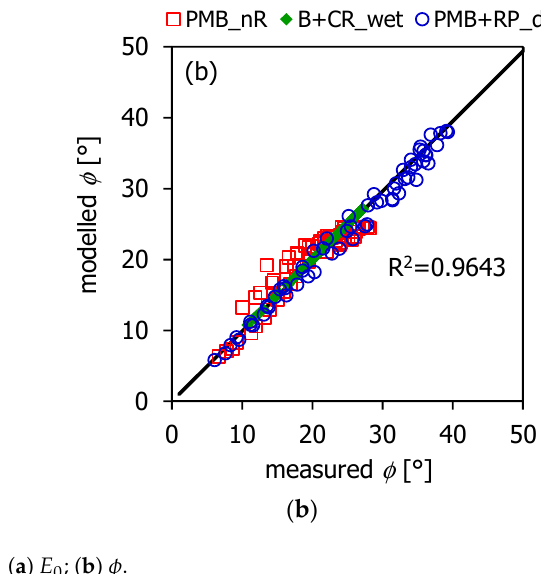
Figure 5. Accuracy of the HS model: ( a ) E 0 ; ( b ) ϕ .